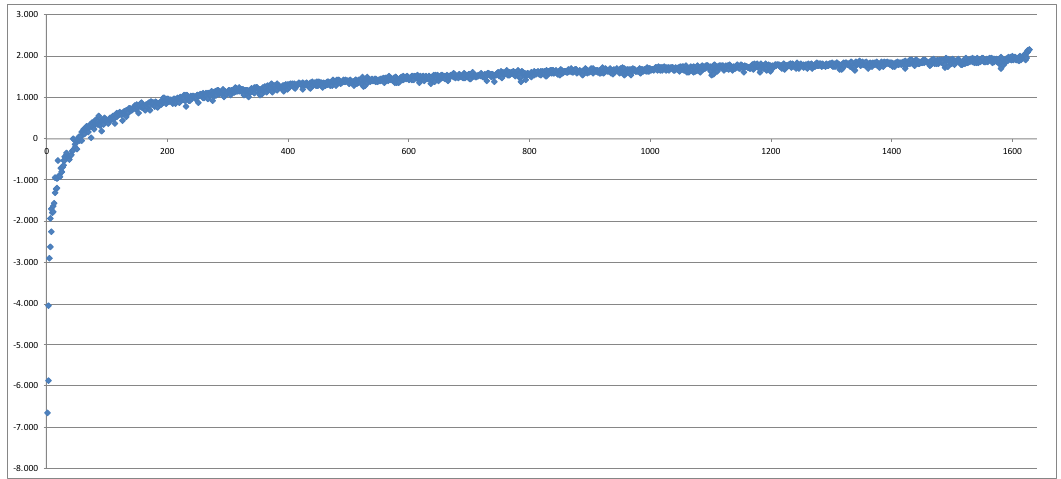
Figure 3. Nested stochastics own funds in the order of LSMC own funds w/o 14